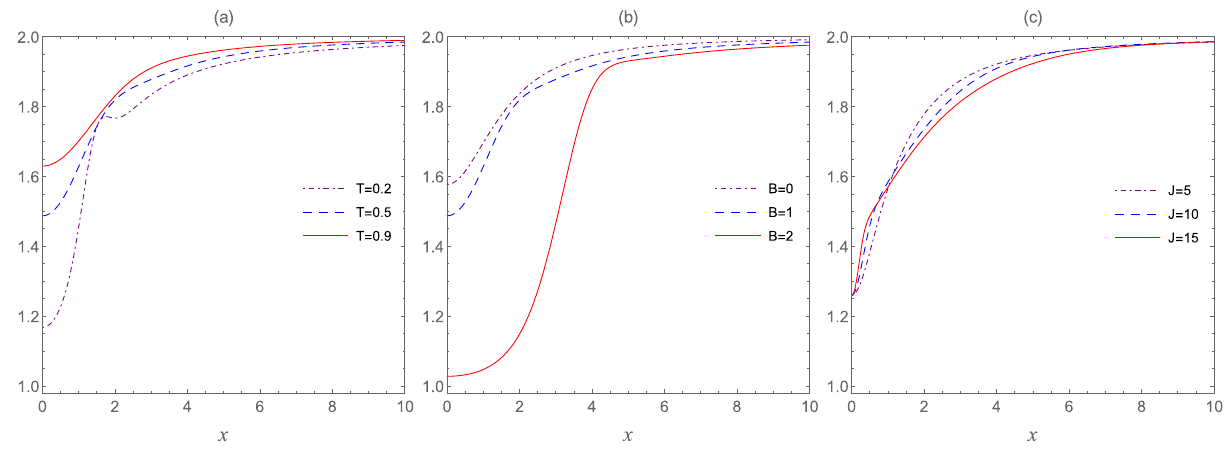
Figure 2. The entropic uncertainty bound U b (ρ T ,1 ) as a function of the inhomogeneity parameter x for fixed values of the temperature T , external magnetic field B , and the coupling constant J . Graph ( a ) B = 1; J = 1 , graph ( b ) T = 0.5 ; J = 1 , and graph ( c ) T = 0.5 ; B = 1.